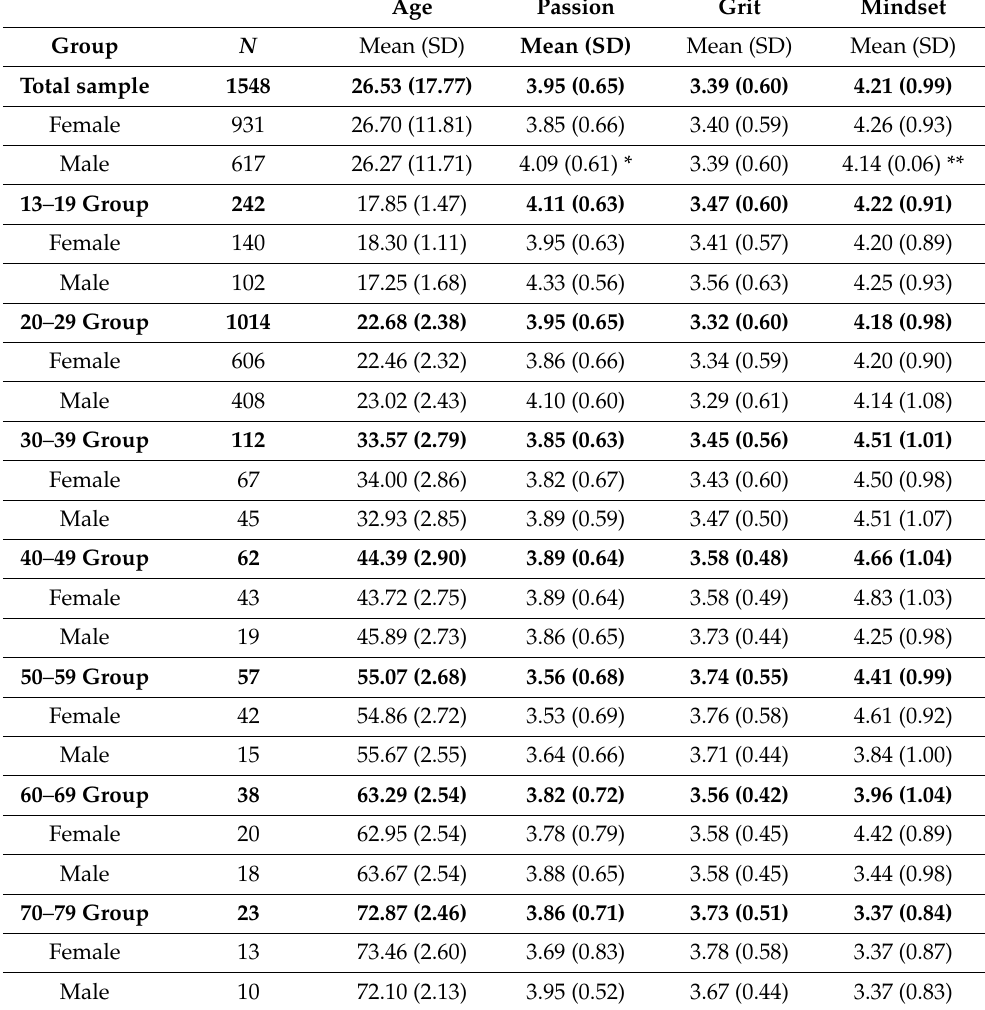
Table 1. Mean scores for age, passion, grit, and mindset for age groups and gender. Age Passion Grit